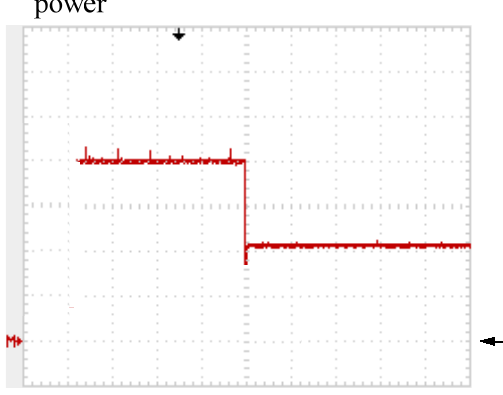
Figure 25. Practical measurement: tracking trajectory of the converter with the DLAA while PV power steps down from 200 to 100 W. Note: power: 50 W/div; time: 0.5